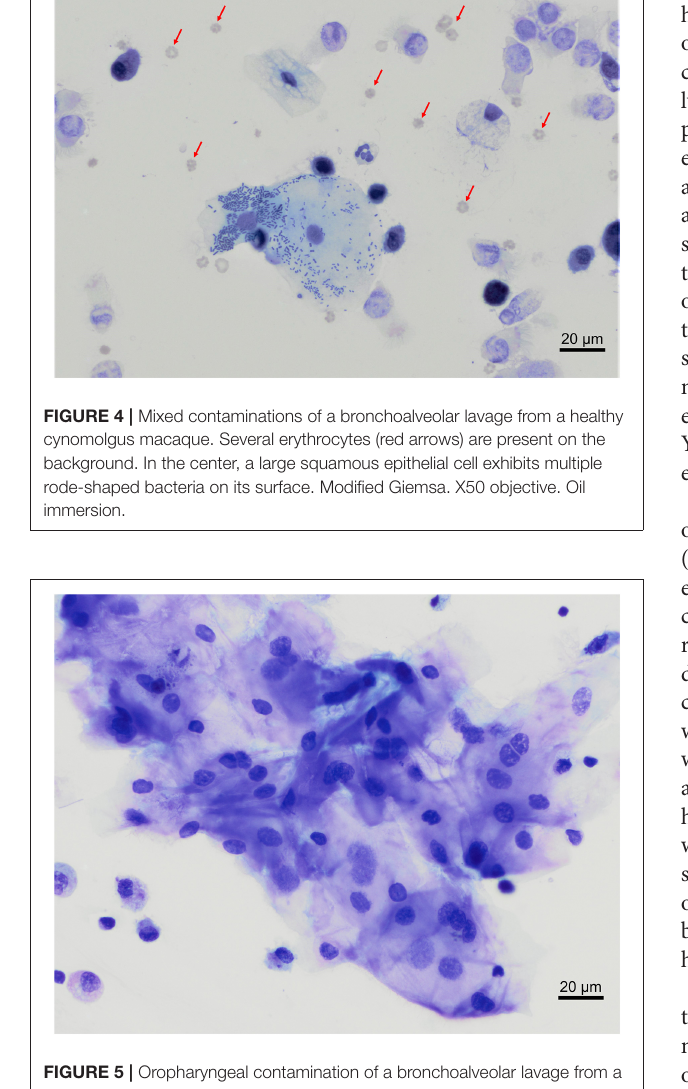
FIGURE 5 | Oropharyngeal contamination of a bronchoalveolar lavage from a healthy cynomolgus macaque. Raft of squamous epithelial cells located in the middle of the image, with low numbers of macrophages and small lymphocytes on the bottom left corner. Modified Giemsa. X50 objective. Oil